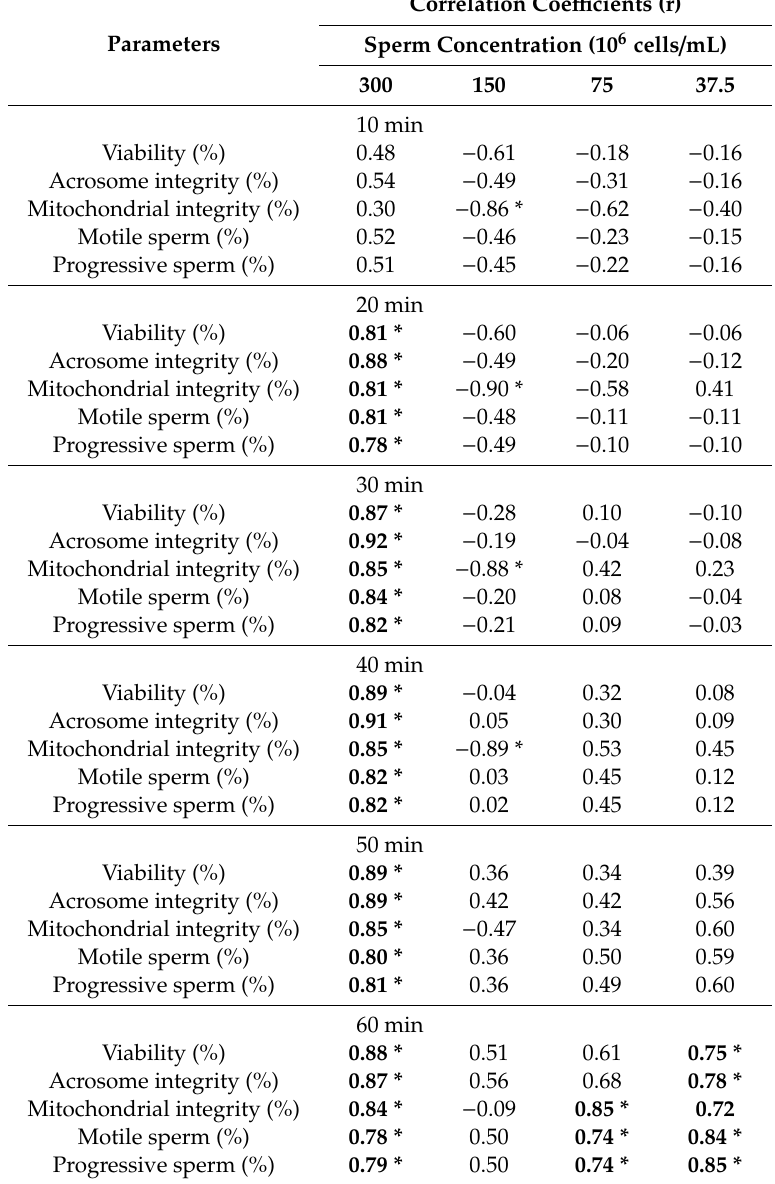
Table 2. Pearson’s correlation coe ffi cients between the 2-[2-methoxy-4-nitrophenyl]-3-[4-nitrophenyl]- 5-[2,4-disulfophenyl]-2H-tetrazolium (WST-8) reduction rate and boar sperm parameters in di ff erent sperm concentrations and incubation